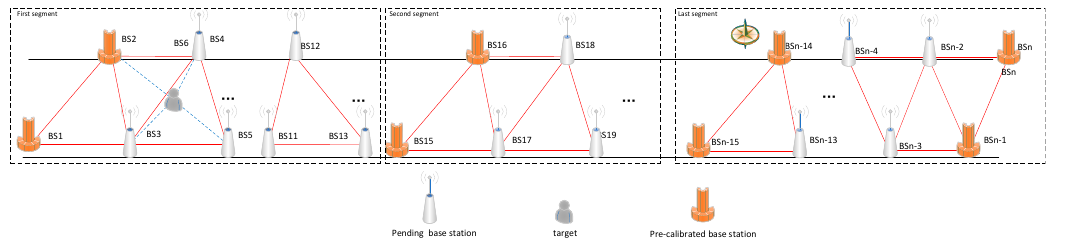
Figure 3. Linear network topology of base stations in the tunnel or mine.